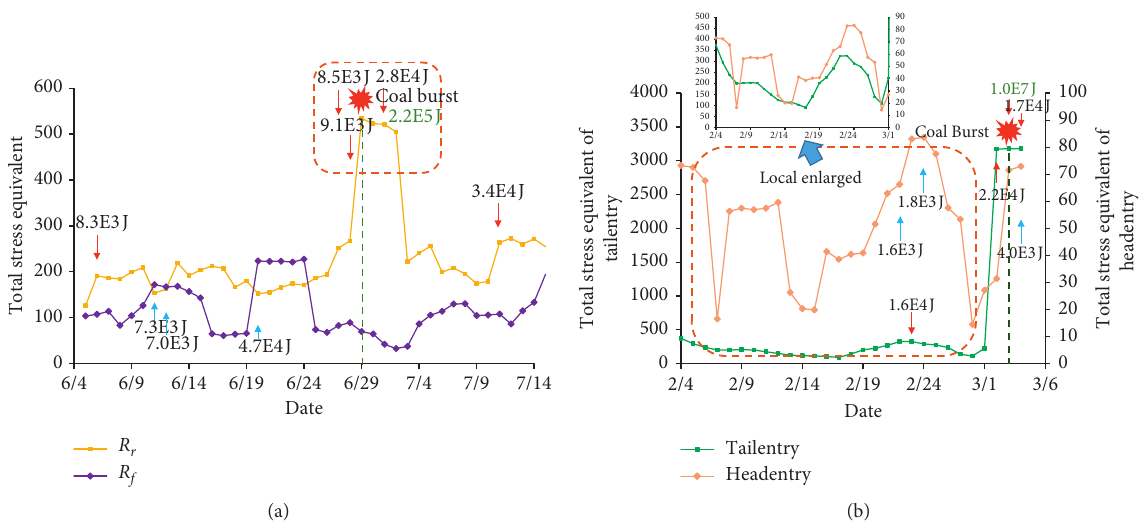
Figure 9: Variation curve of total stress equivalent value. (a) LW5521-20. (b)